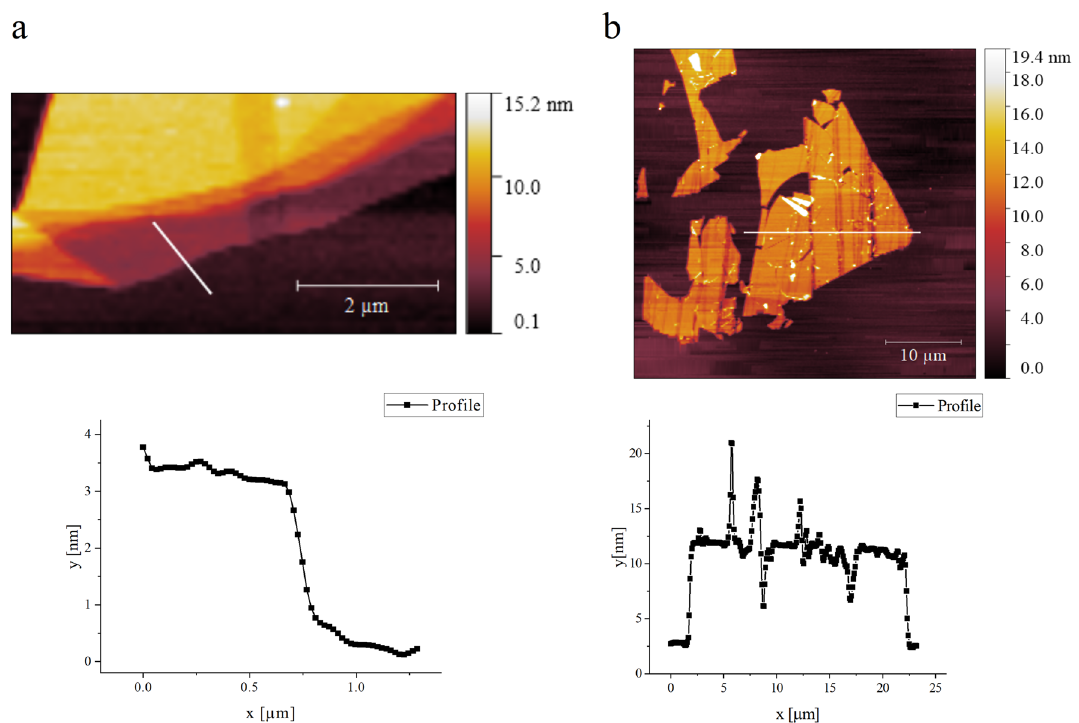
Figure 3. AFM topography images of muscovite mica on Au/Ti/Si substrate. ( a ) Tapping mode image for a 2–3 nm thick mica sheet with a thickness profile taken along the line indicated shown in the plot below. ( b ) Tapping mode image for a 9 nm thick mica sheet with a thickness profile taken along the line indicated shown in the plot